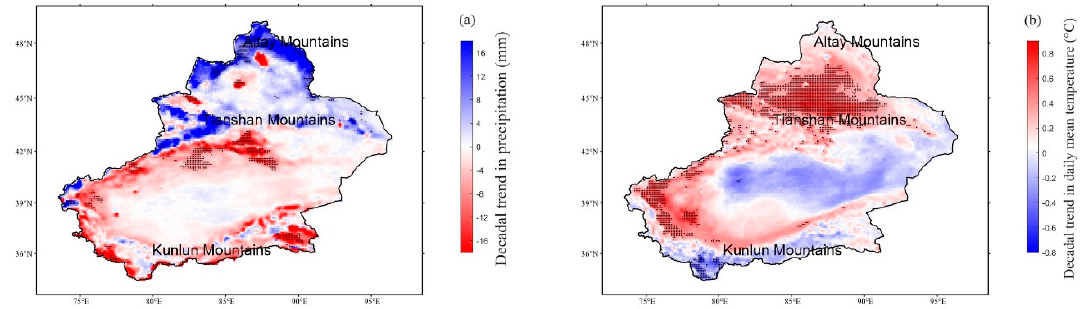
Figure 6. Decadal trends of precipitation ( a ) and temperature ( b ) time series of WRF during the cold season from 1979 to 2015. Black dots represent significance at the 0.05 level.